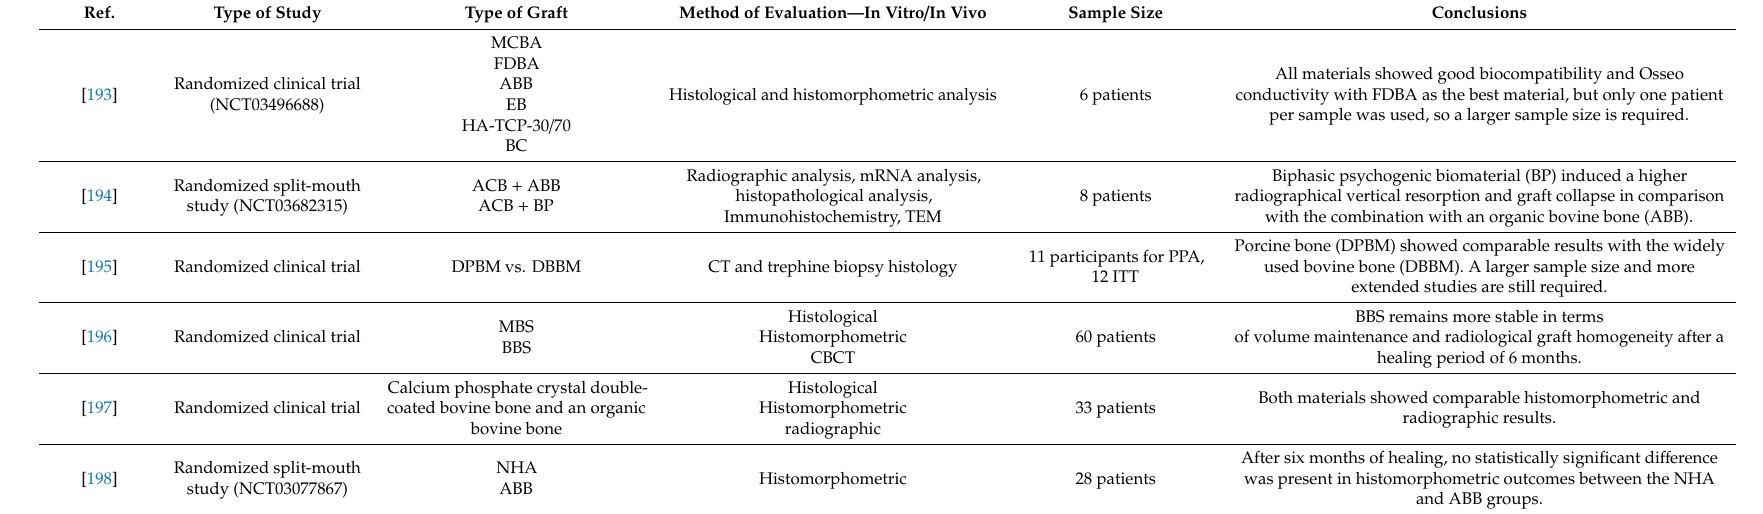
Table 7. Maxillary sinus lift using di ff erent bone grafts in oral and maxillofacial